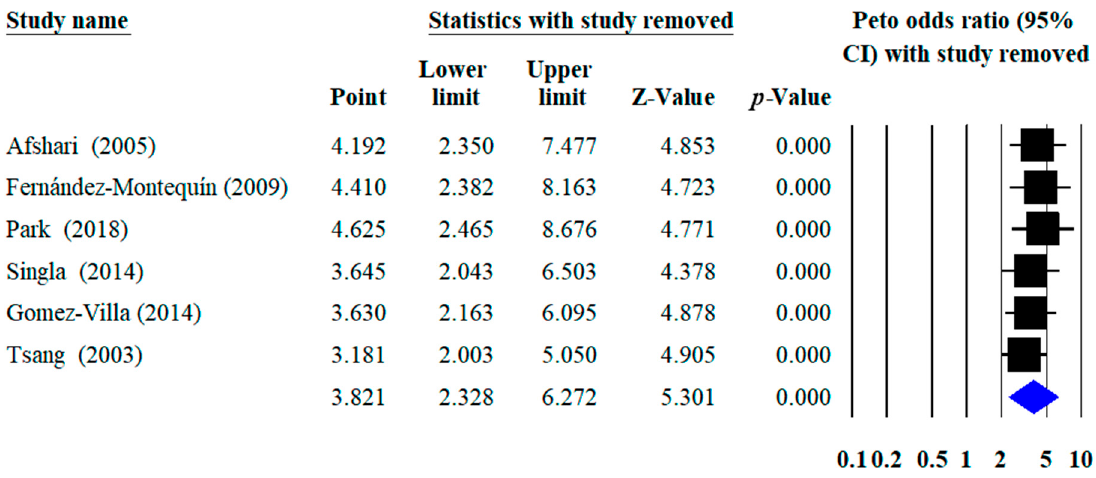
Figure 7. Sensitivity analysis with omitted studies and recalculated odds ratio.